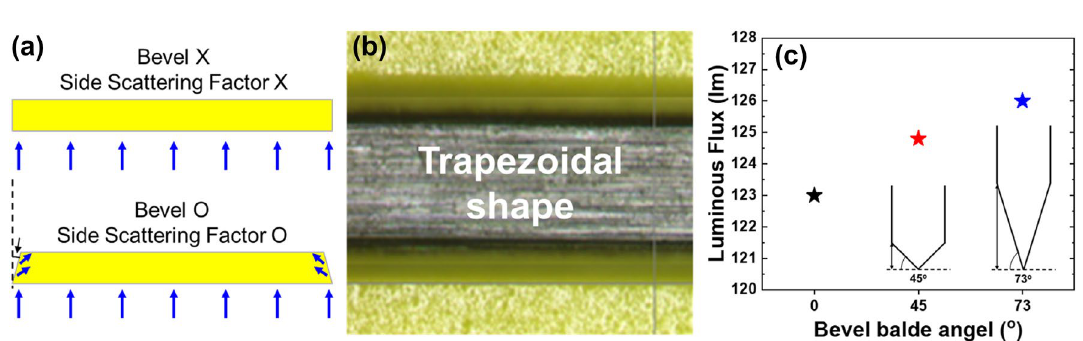
Figure 8. ( a ) schematic diagram of the effect of bevel cutting, ( b ) an optical microscope top view image of the bevel-cut phosphor ceramic, and ( c ) luminous flux with each bevel angle (0, 43,